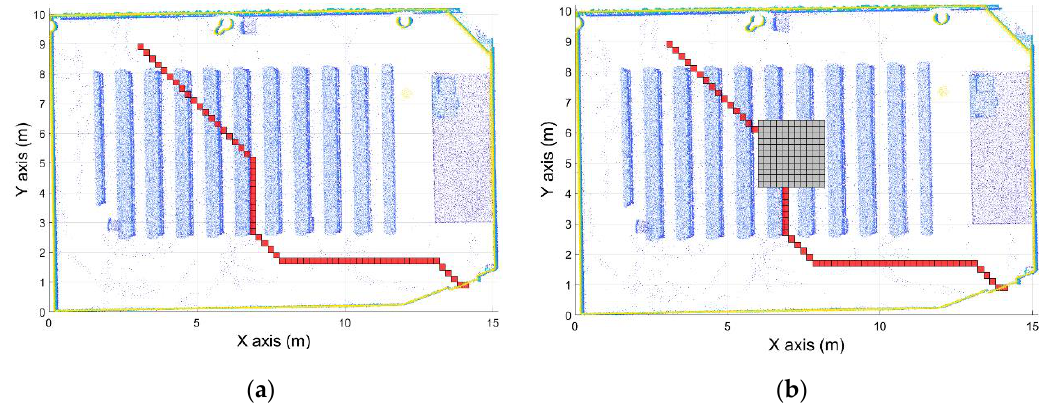
Figure 17. Obstacle detected in the path calculated. ( a ) Initial path calculated. ( b ) Obstacle detected with the security offset around the obstacle defined.